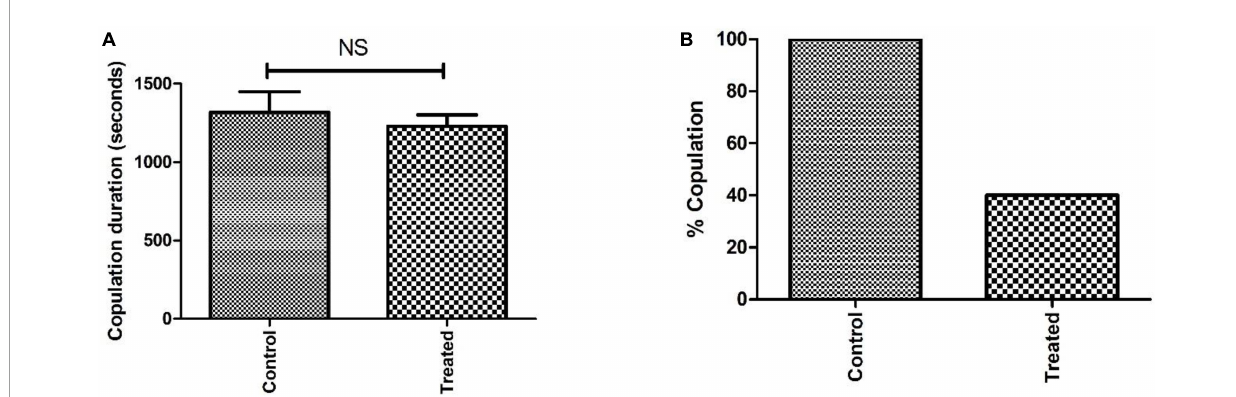
FIGURE6 Analysis of sexual behavior before the onset of mobility defects showed that the difference in copulation duration between control and treatment is not significant (NS) (A) . However, the difference in percent copulation is about 60% less in male-treated mating (20 males mated successfully/25 in the control group and 9/25 in the treated group) when compared to control mating (B)